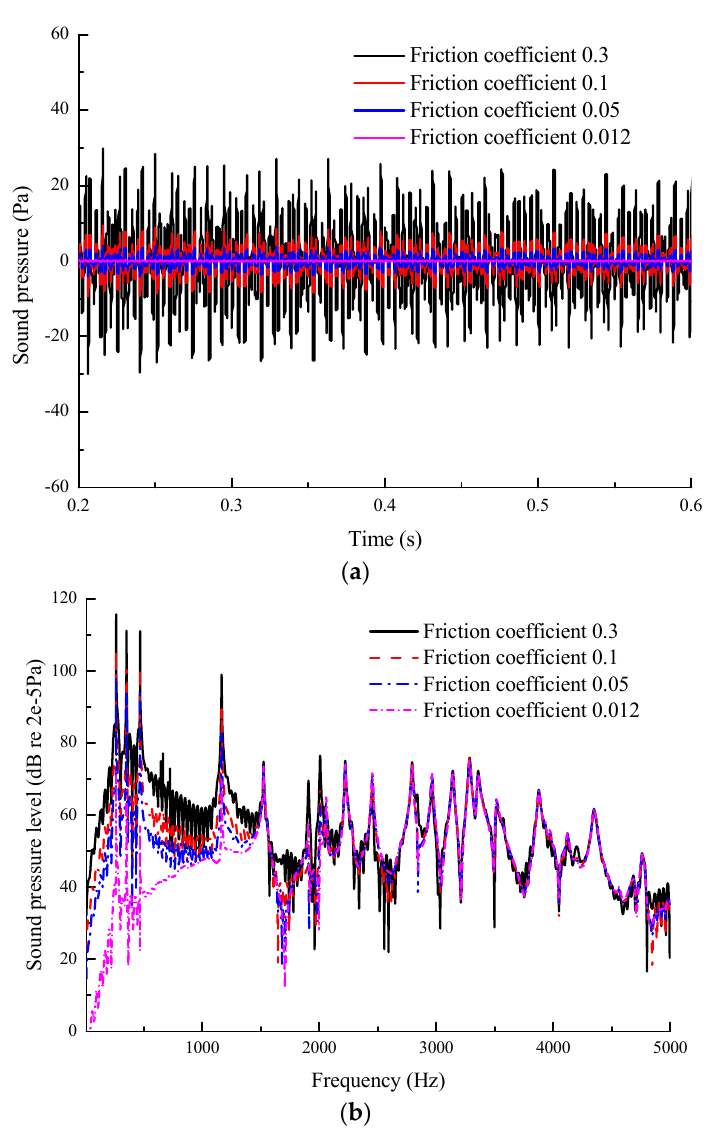
Figure 14. SPLs with different friction coefficients in ( a ) time domain and ( b ) frequency domain (simulation results).